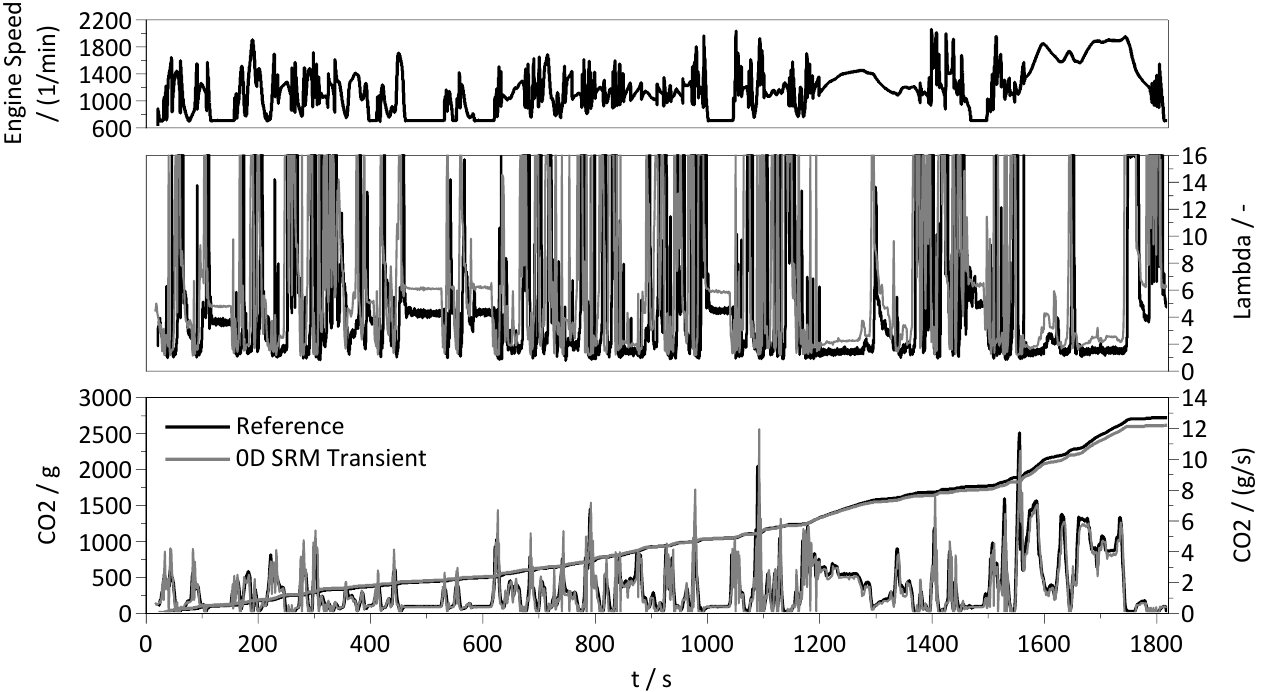
Figure 9. Comparison of lambda, CO 2 mass flows, and cumulative values between the simulation and reference measurements.